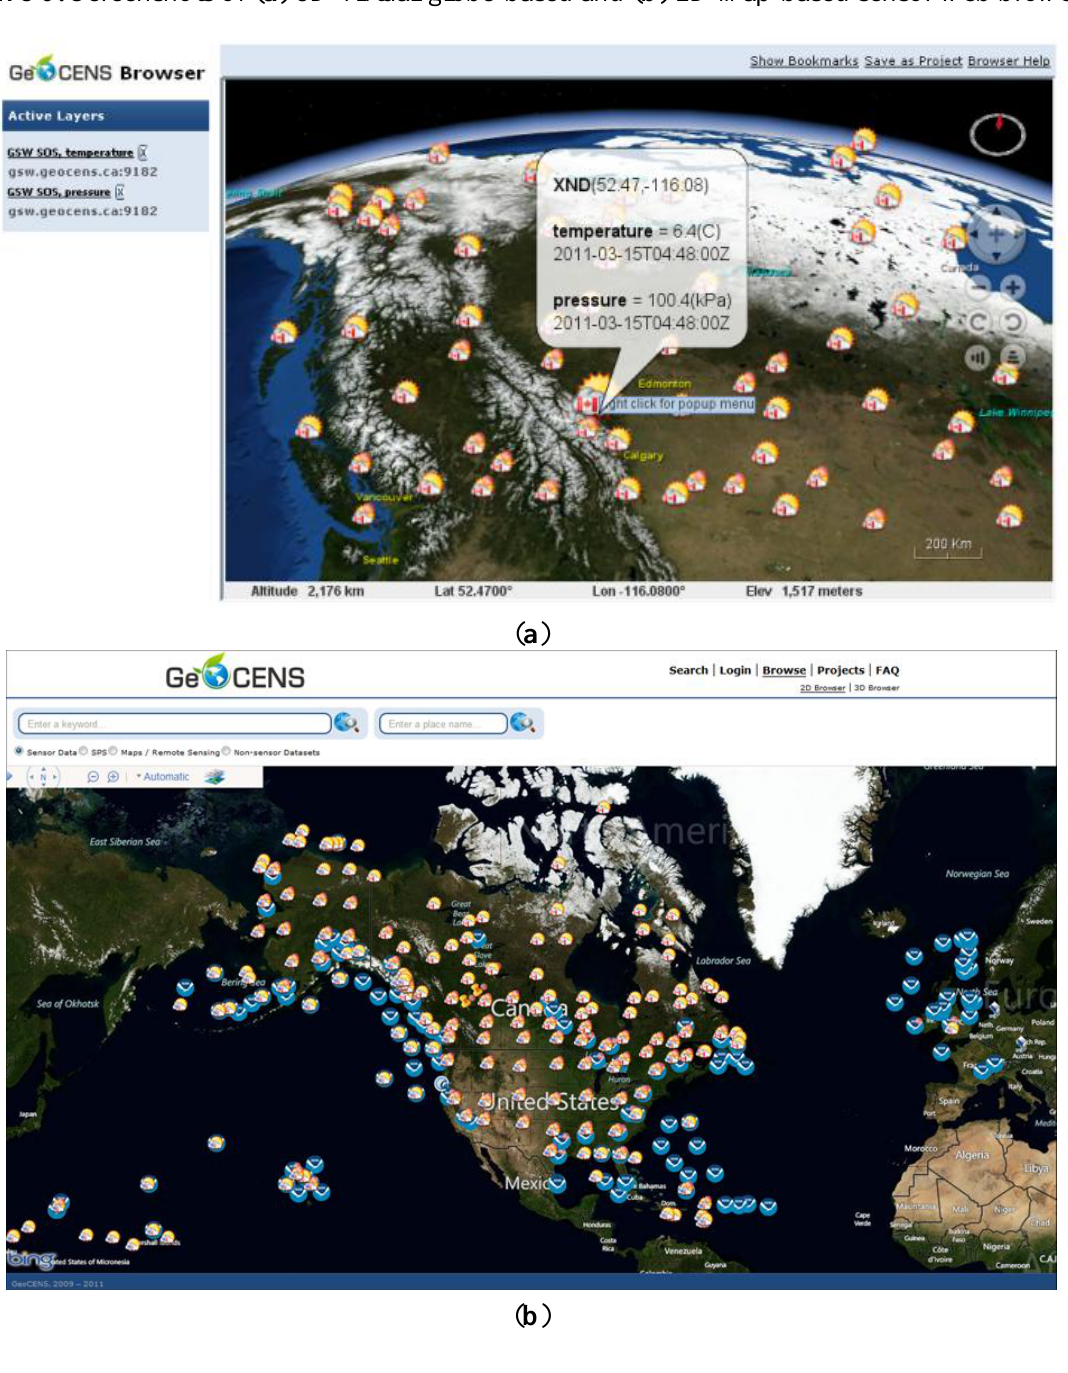
Figure 6. Screenshots of ( a ) 3D virtual-globe-based and ( b ) 2D map-based sensor web